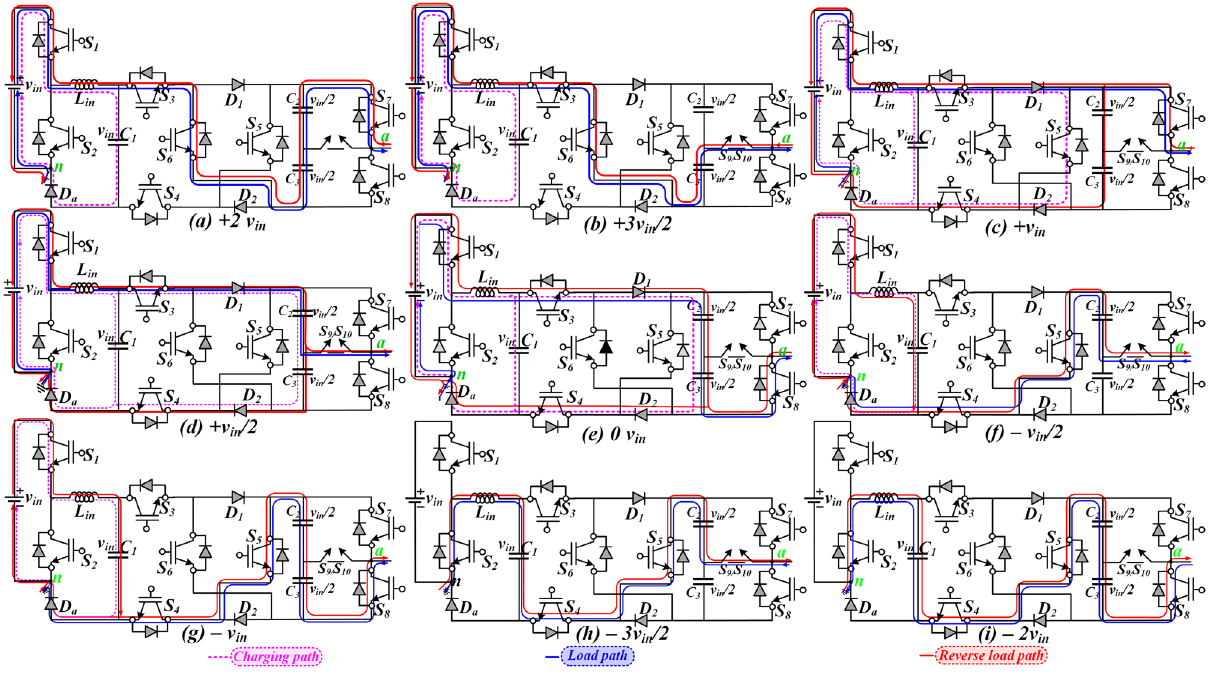
Figure 2. ( a – i ) Modes of operation of the proposed